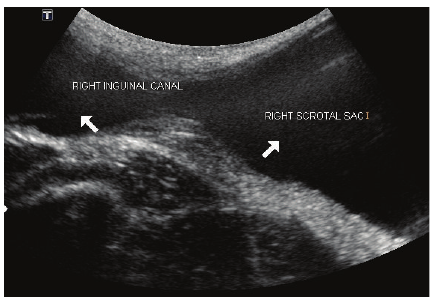
Figure 3: Ultrasound image at the level of right inguinal canal showing anechoic cystic lesion extending into scrotum and abdomen. Right testis is seen in the inguinal